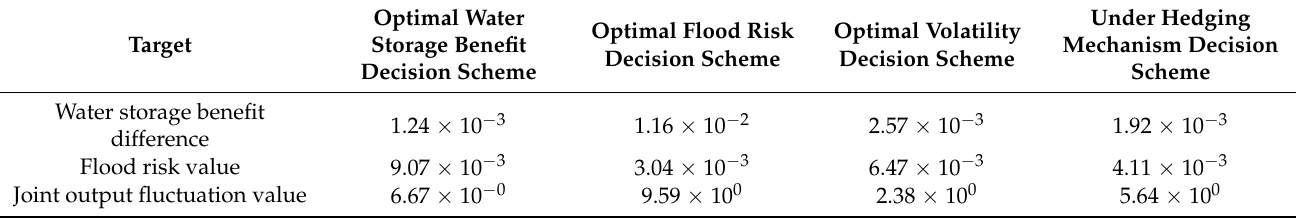
Table 3. The comparison of the optimization goal in the Pareto